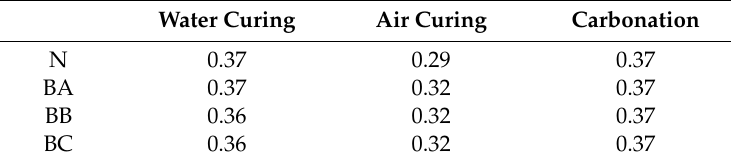
Figure 9. Total pore volume of carbonated cement paste. Table 3. Specific volume of paste samples.